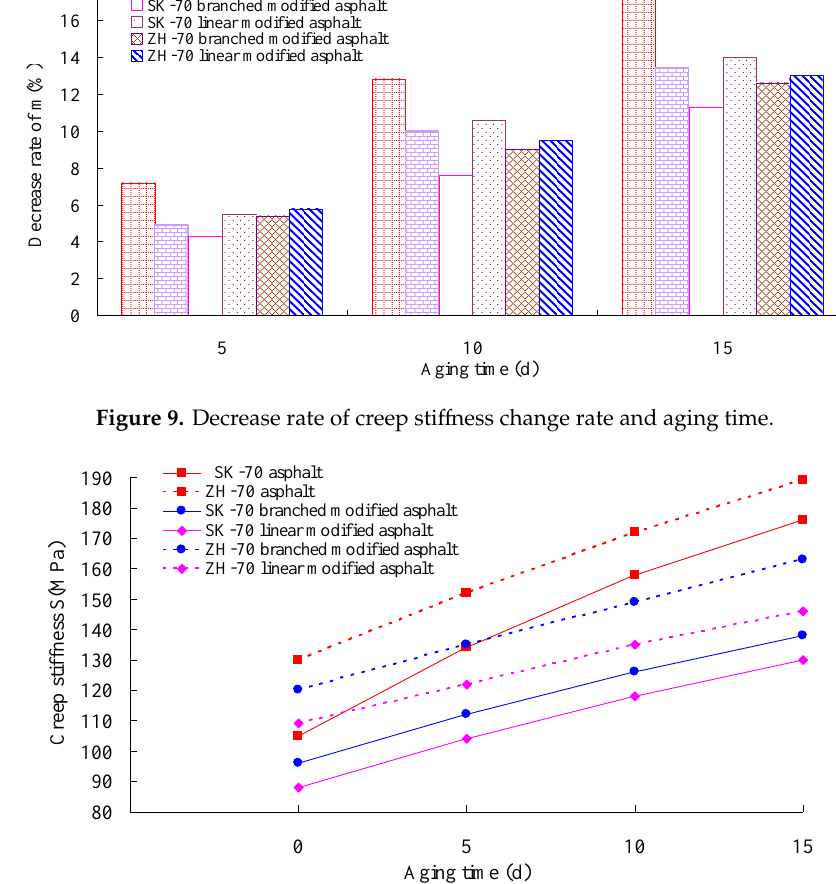
Figure 10. Sti ff ness modulus and aging Figure 10. Stiffness modulus and aging time.